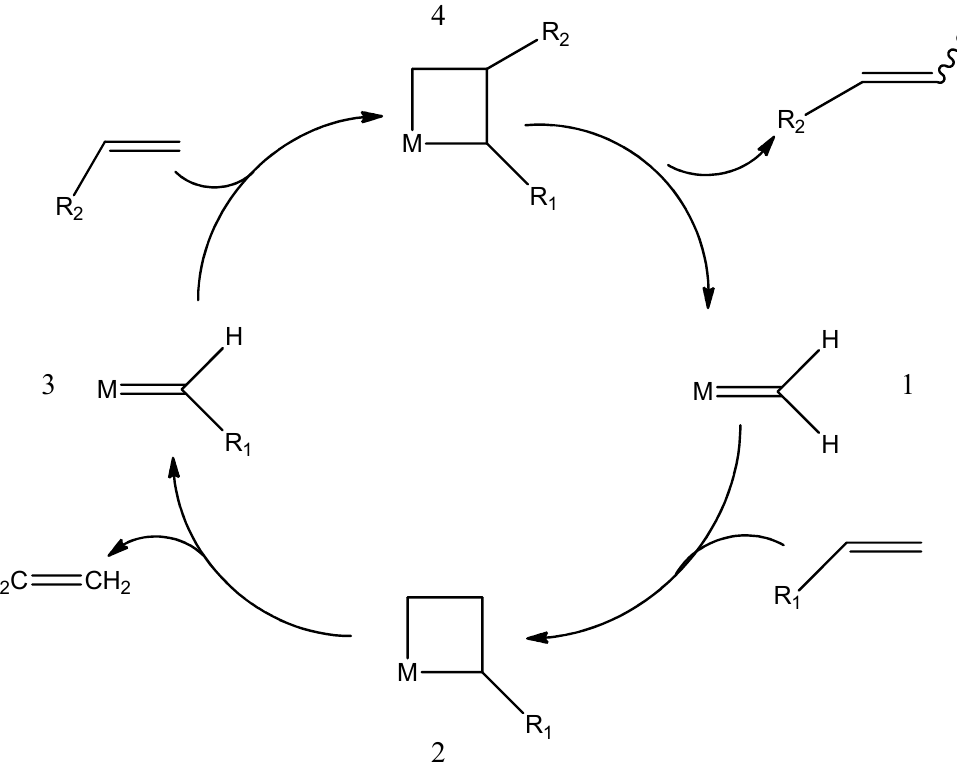
Figure 4. The mechanism of metathesis reaction.